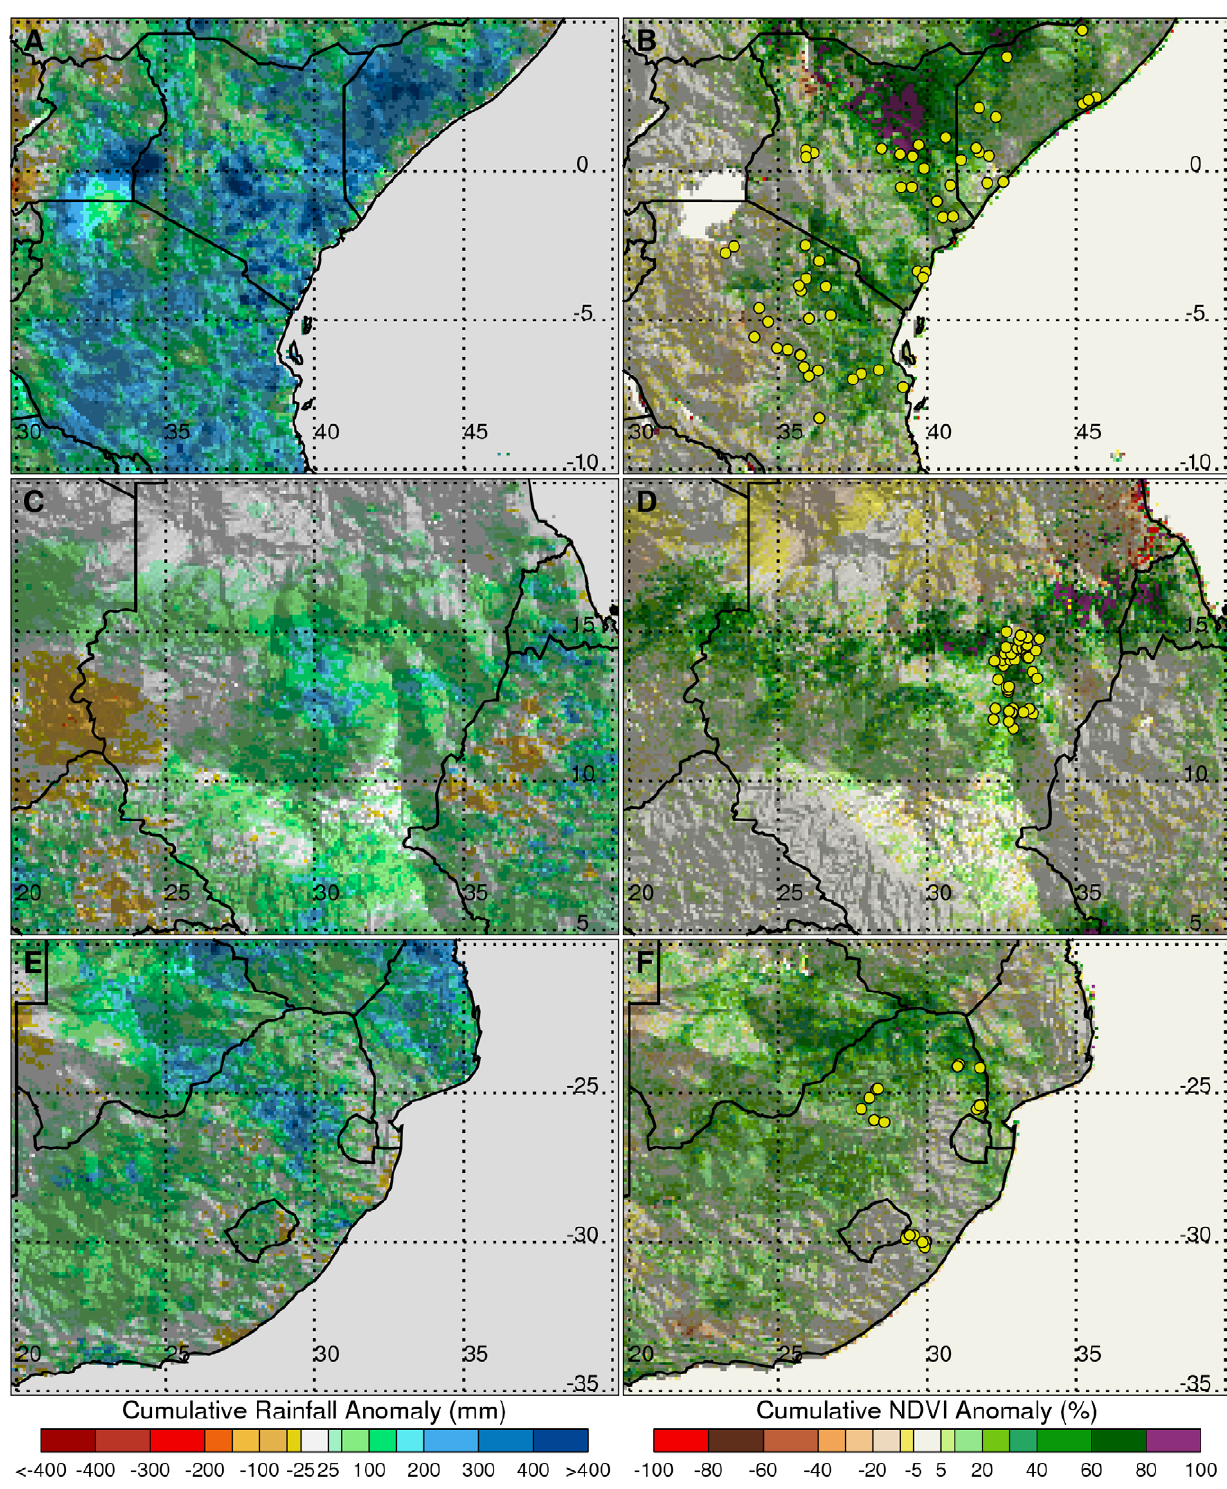
Figure 4. Cumulative rainfall anomalies and vegetation index anomalies for East Africa, Sudan and Southern Africa. Patterns of rainfall anomalies preceding outbreaks of Rift Valley fever in (A) East Africa: September–December, 2006, (C) Sudan: June–September, 2007, and (E) Southern Africa: October, 2007–January, 2008. Each outbreak was preceded by persistent and above-normal rain on the order of + 200 mm for a period of , 2–4 months (Fig. S2). This resulted in anomalous green-up of vegetation, creating ideal ecological conditions for the production of Aedes and Culex mosquito vectors that transmit Rift Valley fever virus to domestic animals and humans. Vegetation anomalies are shown for (B) East Africa: October, 2006–January 2007, (D) Sudan: July–September, 2007, and (F) Southern Africa: October, 2007–January, 2008. Rift Valley fever outbreaks are marked with yellow dots.